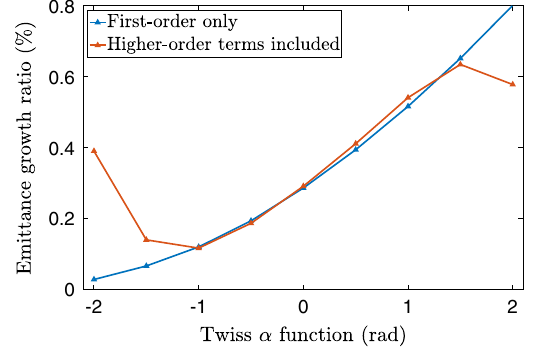
FIG. 9. Emittance growth ratio driven by the CSR effect. The blue curve indicates the ratio with the first-order matrix, whereas the orange curve represents the ratio with the higher-order terms of the transfer map.